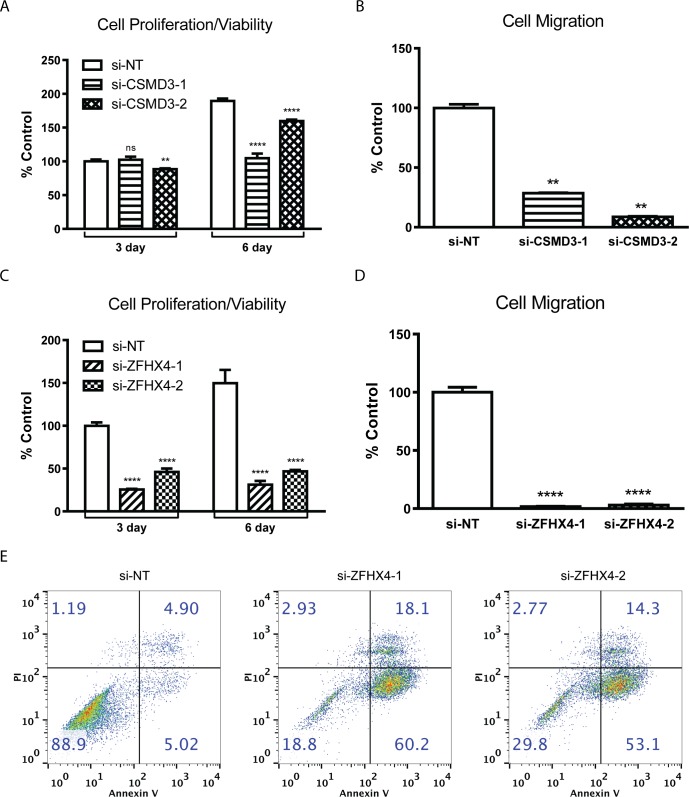
Cell biology evaluation of oncogenic properties of CSMD3 and ZHFX4.A-B. The impact of knocking down CSMD3 and ZFHX4 on cell proliferation. C-D. The impact of knocking down CSMD3 and ZFHX4 on cell migration. E. Impact of ZFHX4 knockdown on apoptosis in PC3 cell line measured by Annexin V and propidium iodide (PI) staining.